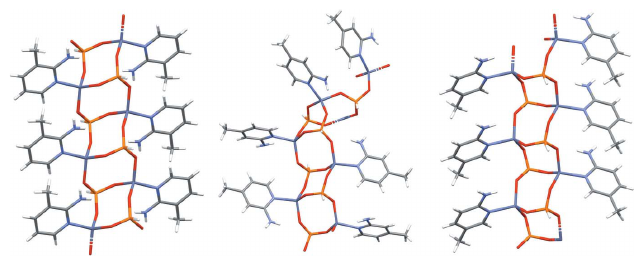
Figure 6 Comparison of the zincophosphite 4-ring ladder chains in the extended structures of (I) (left), (II) (centre) and (III) (right).